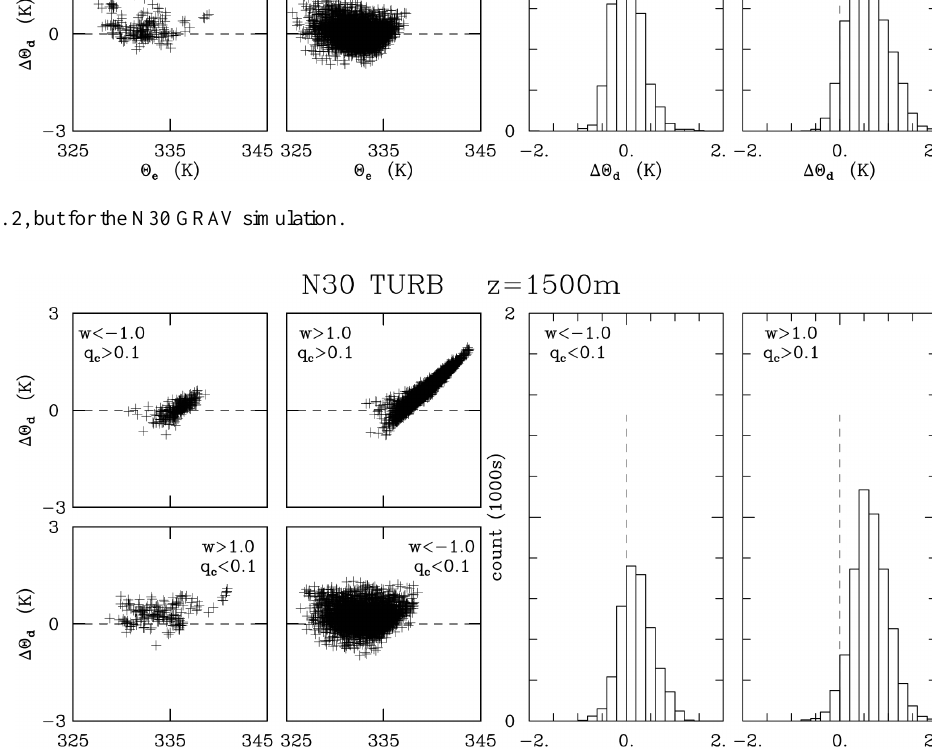
Figure 4. As Fig. 2, but for the N30 TURB